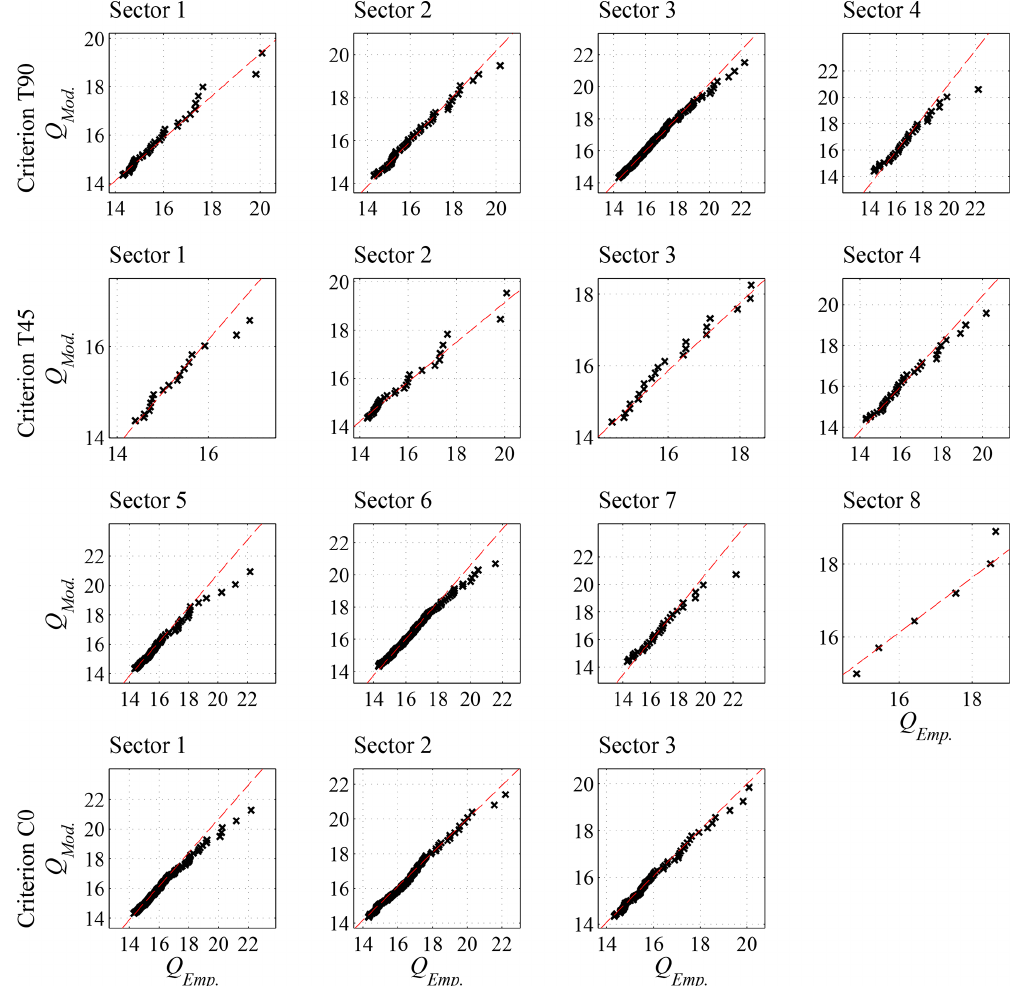
Figure 7. Quantile plots for the fitted model in each sector (empirical quantile on the x axis and model quantile on the y axis). T90: row 1; T45: rows 2, 3; C0: row